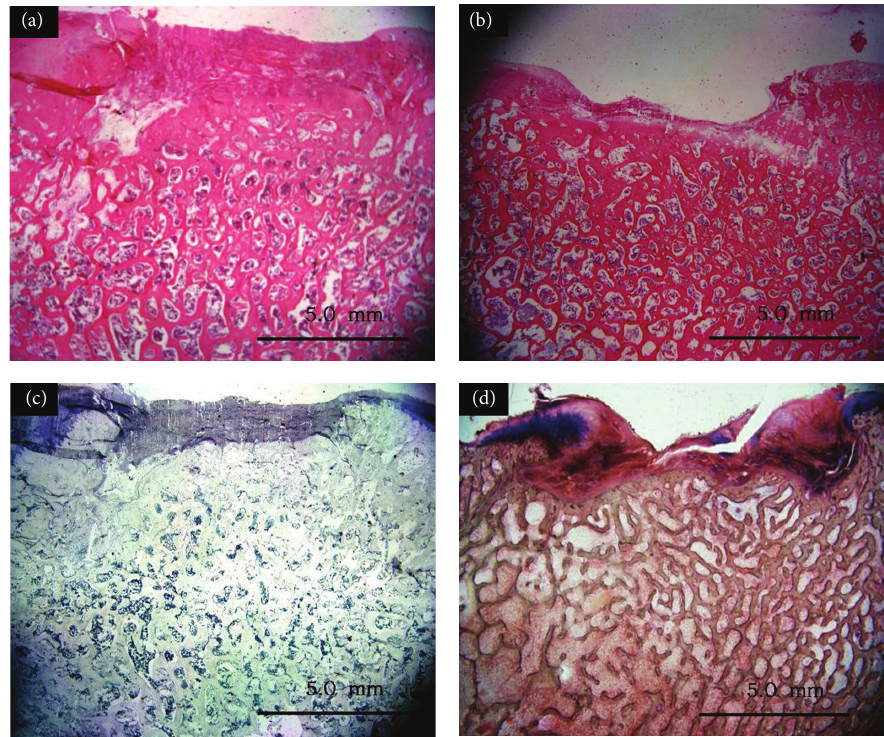
Figure 7: Histology of cell-scaffold complexes: hematoxylin and eosin staining at (a) 3 months and (b) 6 months; toluidine blue staining at (c) 3 months and (d) 6 months. Bar = 5mm.